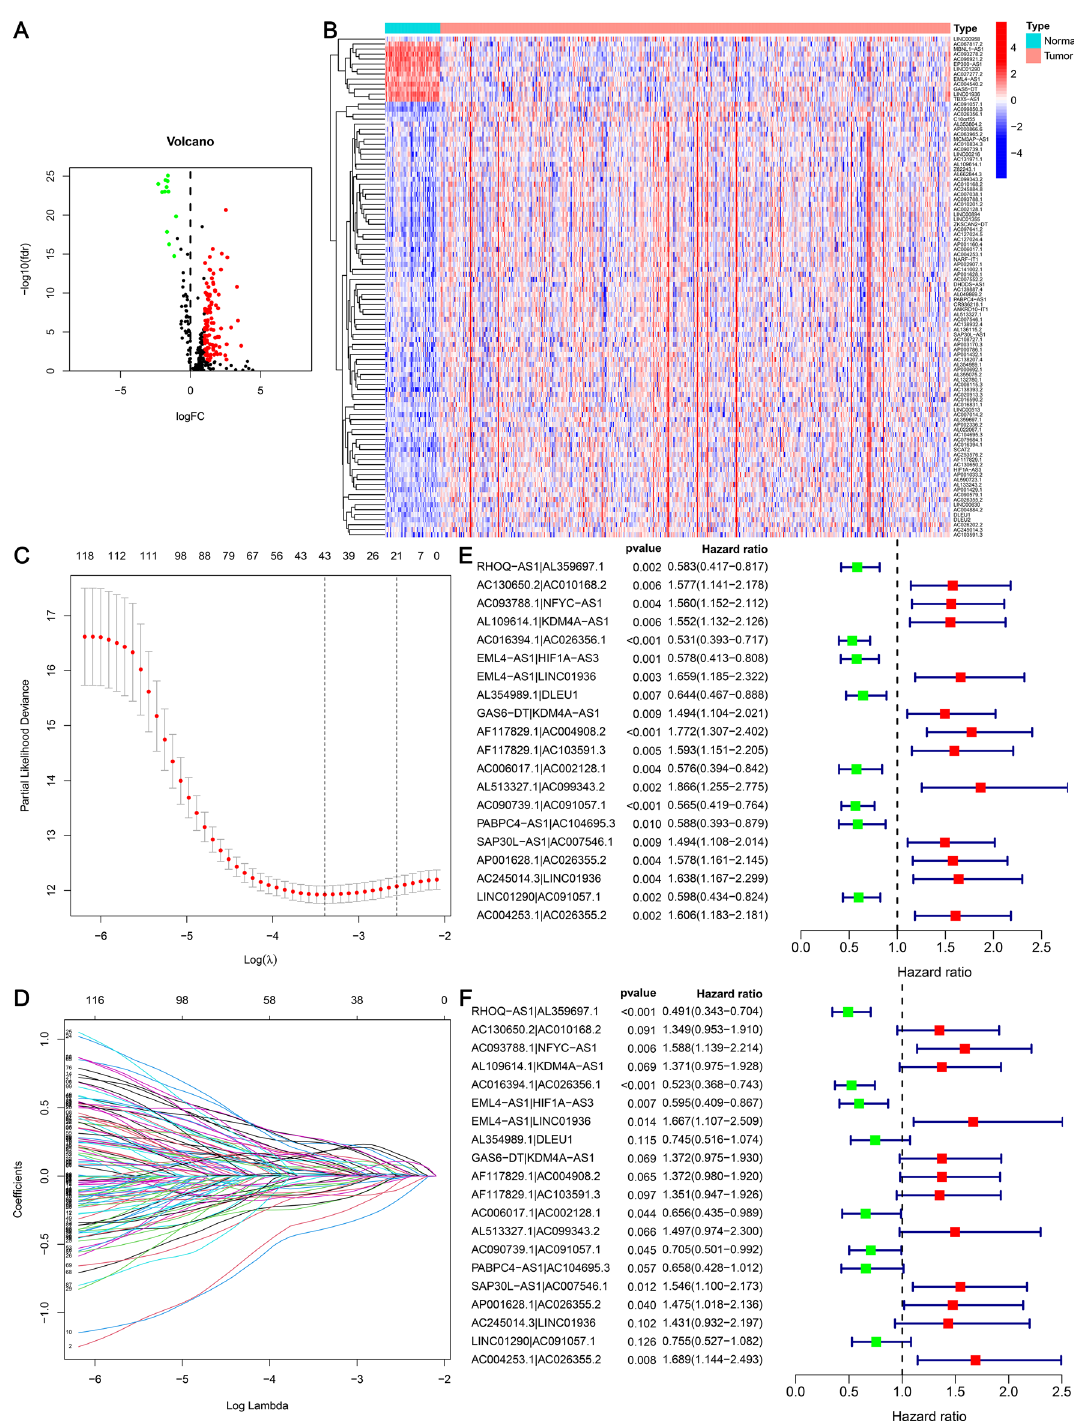
Figure 2. Differential expression analysis of aging-associated lncRNAs in LUAD and generated heatmaps and volcano plots. ( A ) Volcano plot. Red dots: Elevated expression levels of lncRNAs; green dots: downregulated lncRNAs; black dots: lncRNAs with no substantial difference. ( B ) Heatmap. Azure: samples from the normal group; orange: samples from the tumor group; red: high expression of aging-related lncRNAs; blue: low expression of aging-related lncRNAs. The “pheatmap (version 4.13)” packages in R was used to draw heatmap. We downloaded the R software (version 4.13) from the official website (https:// mirro rs. tuna. tsing hua. edu. cn/ CRAN/). ( C ) The LASSO coefficient profile of 20 aging-related lncRNAs. ( D ) The cross-validation for variable selection in the LASSO model. ( E ) Forest plot of Cox univariate regression analysis. ( F ) Forest plot of Cox multivariate regression analysis. Red: Risk factors; green: protective